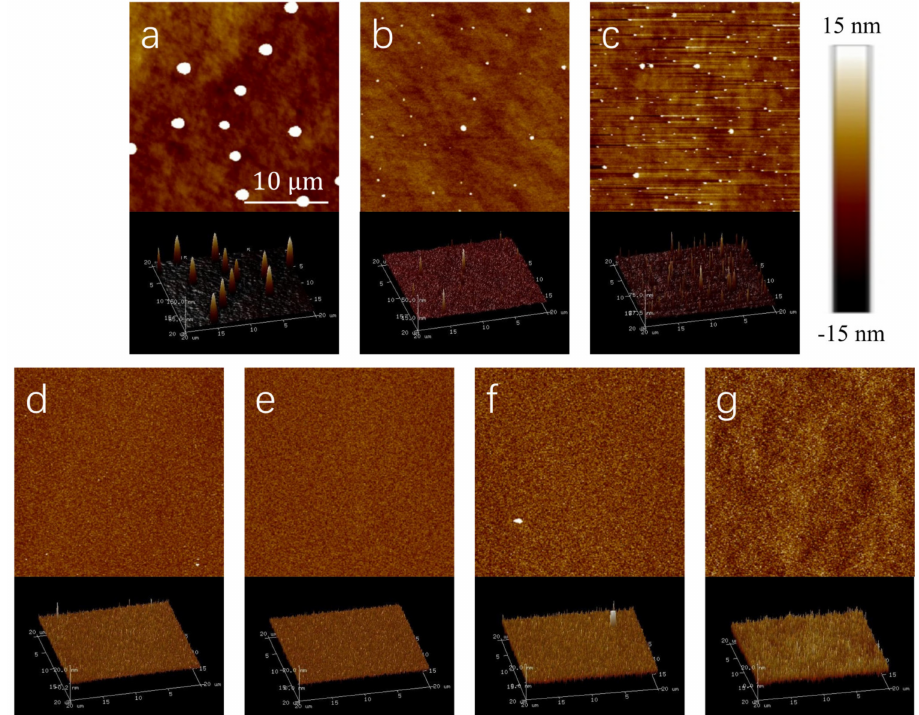
Figure 1. Typical AFM images of annealed seed layer with different ZnAC/PVA volume ratios. ( a ) 0.027:1, ( b ) 0.055:1, ( c ) 0.11:1, ( d ) 0.22:1, ( e ) 0.44:1, ( f ) 0.72:1 and ( g ) 0.87:1. The scanning range of each sample is 20 × 20 µ m 2 , and all images use the same scale